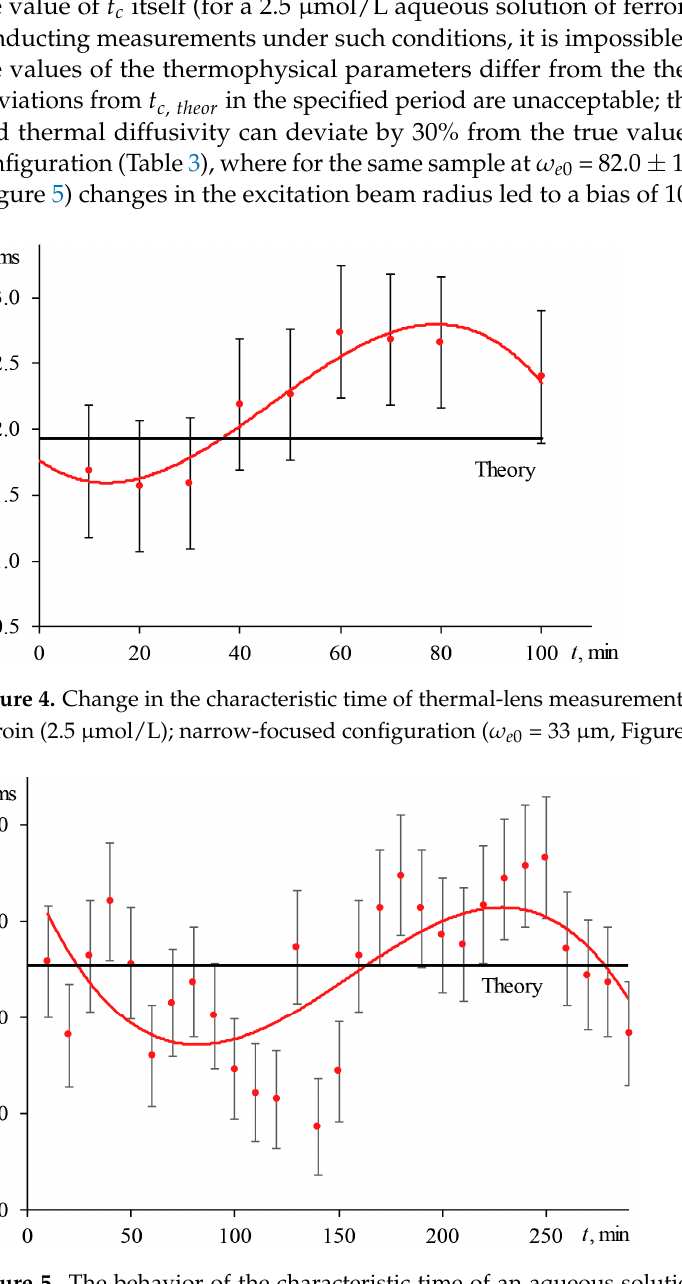
Figure 6. Behavior of the characteristic time of an aqueous solution of ferroin (2.5 µmol/L) with measurements on a wide-focused configuration ( 𝜔 (cid:3032)(cid:2868) = 82 µm, Figure 2, Table 3) for a long period. Summarizing, one can conclude that, having a laser with a long-term systematic change in divergence of ca. 22.4% and short-term fluctuations of 10%, a deviation from